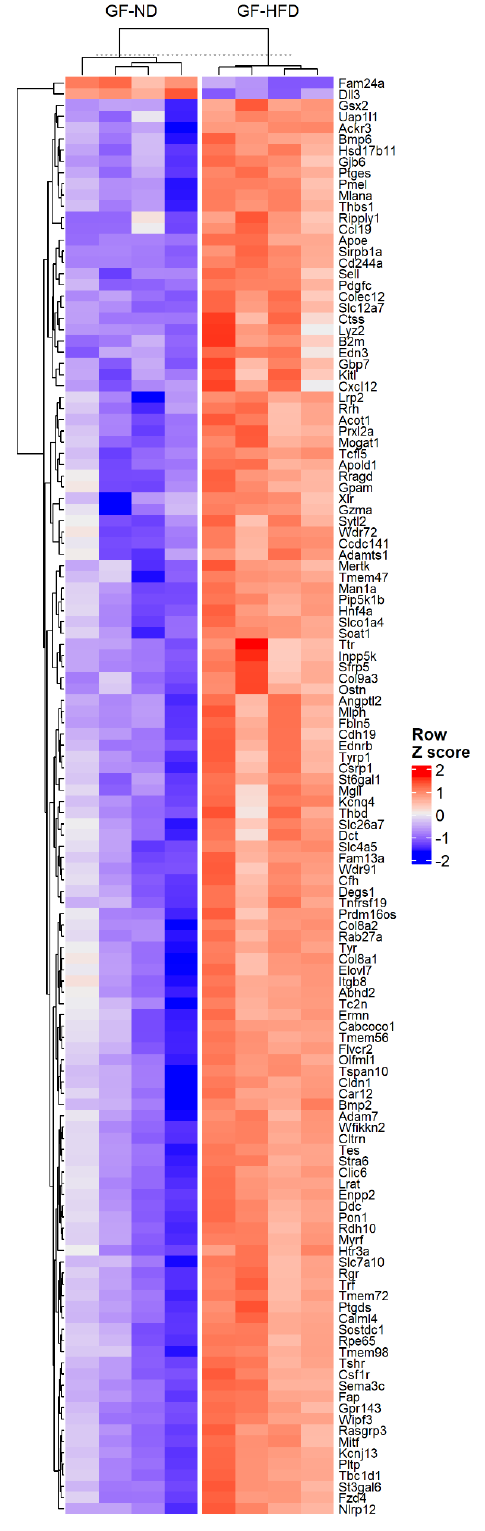
Figure 1. Heatmap with hierarchal clustering demonstrating DEGs with |LogFC| > 1.5 and adjusted p -value < 0.01 between germ-free mice on normal diet (GF-ND, n = 4) and germ-free mice on high-fat diet (GF-HFD, n = 4). Z-score was calculated using LogFC values, with red and blue colors indicating upregulated and downregulated genes,